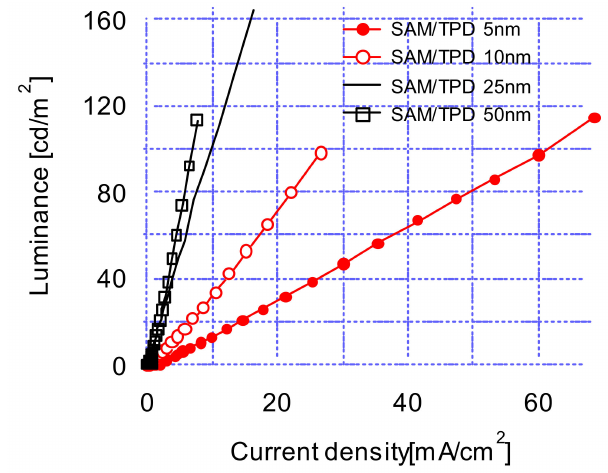
Figure 4. Luminance-current density characteristics of Organic Light-Emitting Diodes (OLED) devices at 5, 10, 25, 50 nm N , N (cid:48) -diphenyl- N , N (cid:48) -di(m-tolyl)-benzidine (TPD)